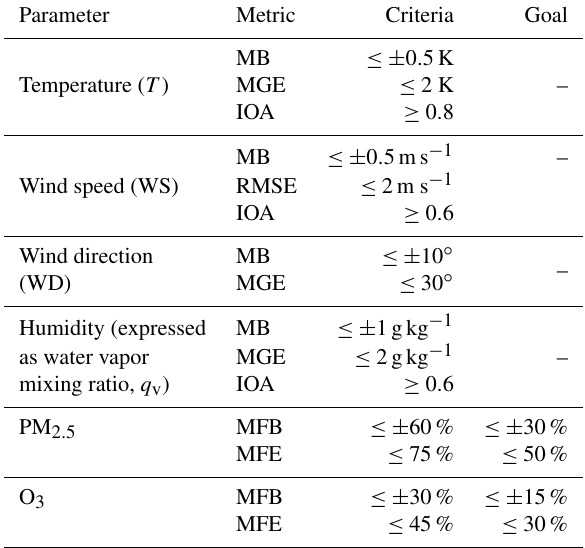
Table 2. Performance criteria and goals for model results (from Emery et al., 2001; EPA, 2007; Boylan and Russel,